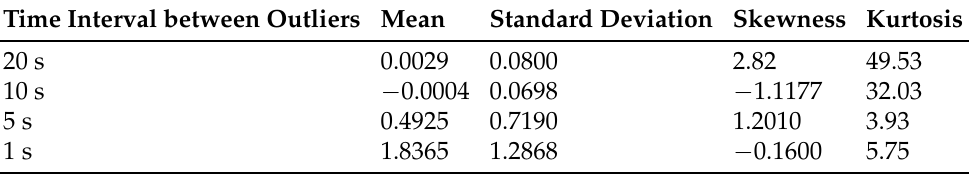
Table 5. Statistical Measures of plant identification error using the MSE